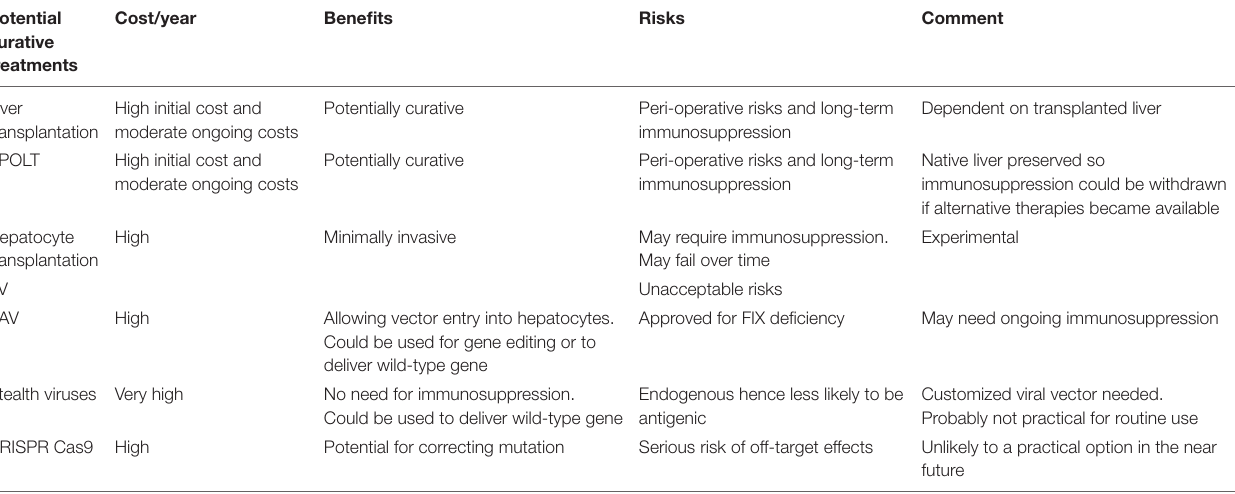
tAbLe 2 | Potentially curative options for patients with types 1 and 2